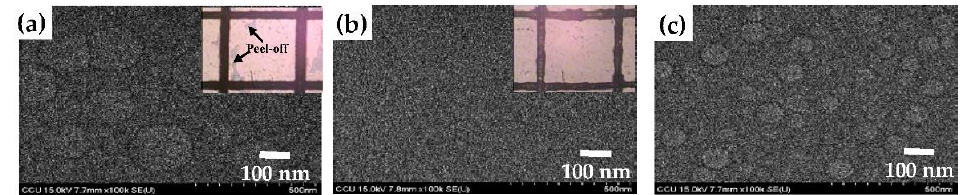
Figure 6. Surface morphologies of the films synthesized from the gas flow ratios of ( a ) 0; ( b ) 0.5; and ( c ) 1, respectively (the inset figures show the tape-peeling test result).